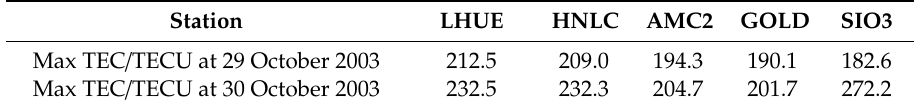
Table 2. Maximum TEC observed at 29 October 2003 and 30 October 2003 at five selected stations.